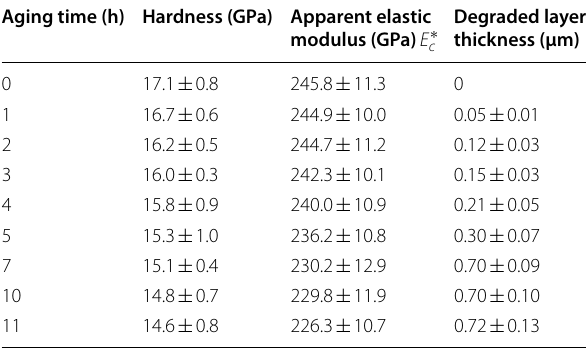
Table 3 Hardness, elastic modulus and degraded layer thickness of the different samples of dental implants in relation to the ageing times